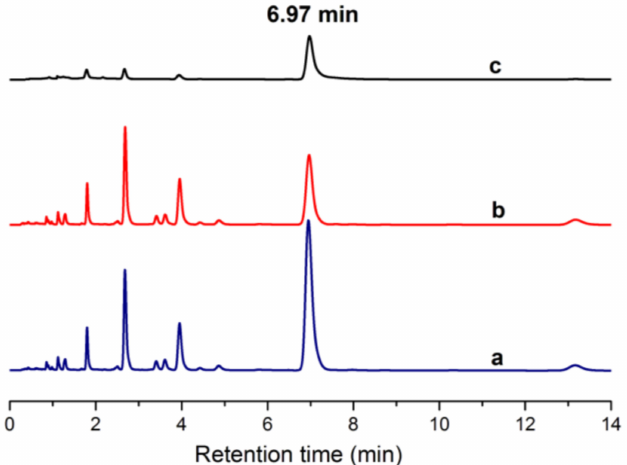
Figure 14. Ultra high performance liquid chromatography (UHPLC) chromatograms of the original solution of Euphorbia fischeriana extract ( a ), the residual solution of Euphorbia fischeriana extract ( b ) and the permeate solution through the membrane ( c